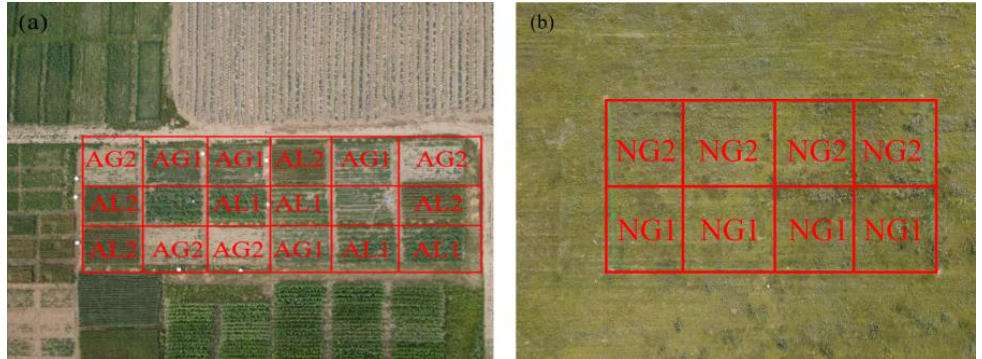
Figure 7. Map of the experimental site. ( a ) Artificial grassland and cropland. ( b ) Natural grassland AG1: Medicago sativa , AG2: Bromus inermis , AL1: Solanum tuberosum , AL2: Avena sativa , NG1: Enclo- sure, NG2: Cutting. The blank area in ( a ) is the installation and storage area of experimental equip- ment.